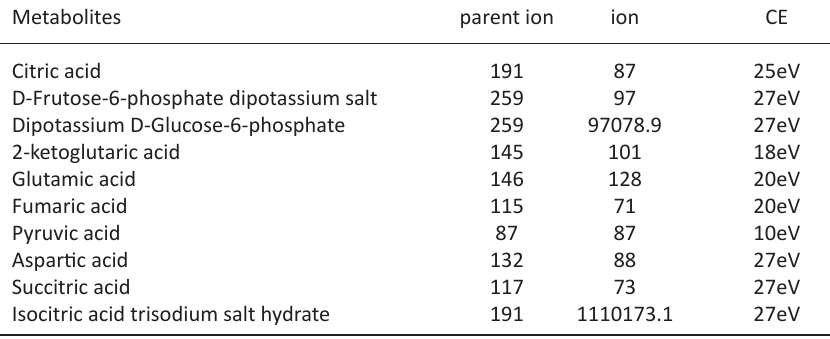
Table 2. The parameters of ten kinds of metabolites detected by ion trap mass spectrometry